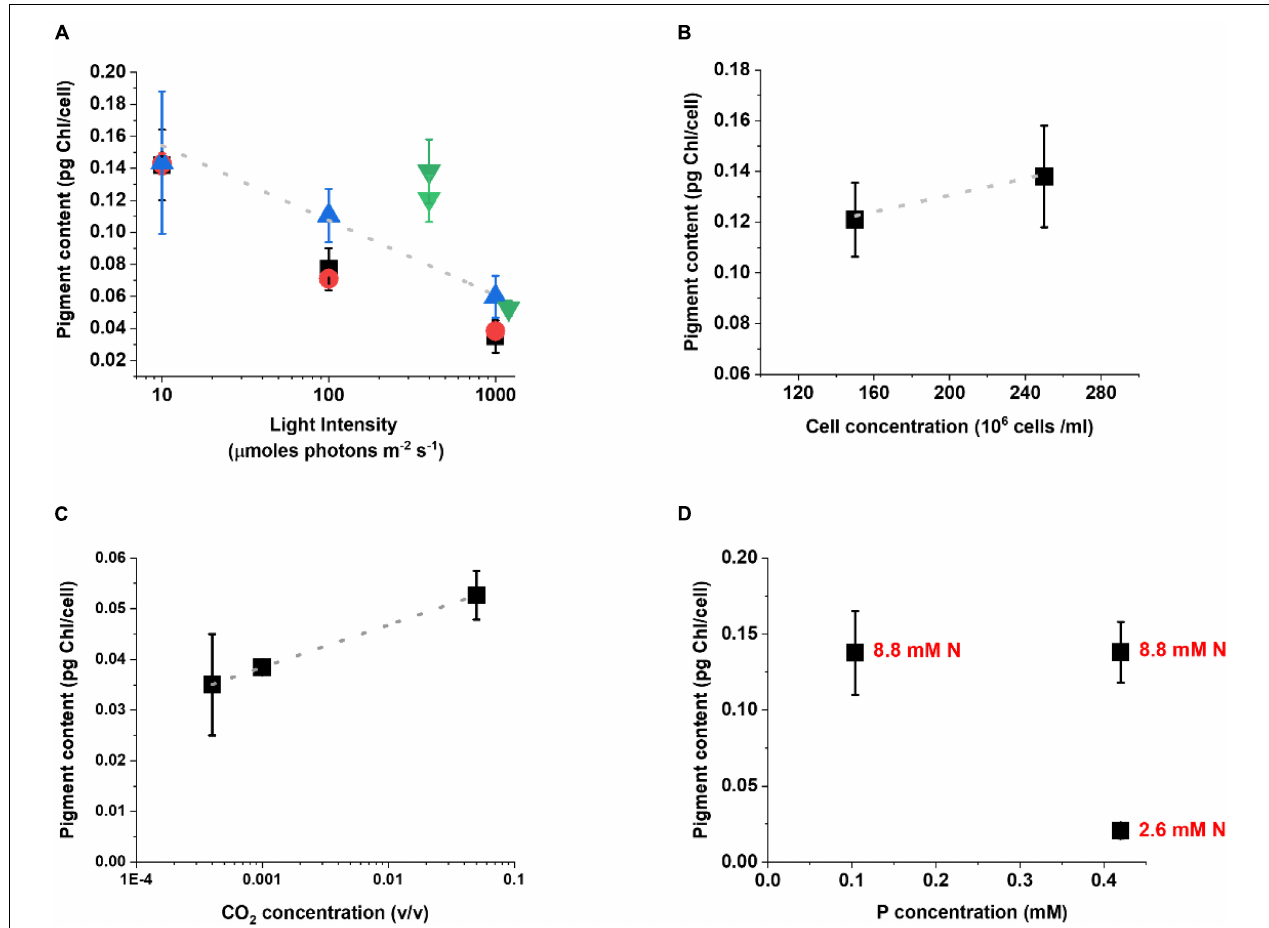
FIGURE 3 | Acclimation response of Nannochloropsis gaditana in a plethora of lab-scale growth conditions. Acclimation is expressed as the change in the Chl content [picograms (pg) of Chlorophyll per cell] as a function of different cultivation parameters, as follows: light intensity (A) ; cell concentration (B) ; CO 2 concentration (C) and nitrogen (N) and phosphorus (P) availability (D) . In panel (A) the trend of Chl reduction as the light intensity increases is maintained regardless of the differences in cultivation support, nutrient, and CO 2 supply. Black squares, data from flasks, both nutrients and carbon are limiting; Red circles, data from lab-scale glass tubes with air bubbling; Blue upward tringles, data from lab-scale glass tubes with air bubbling and excess nutrients; Green downward tringles, data from lab-scale photobioreactors with excess carbon (see Supplementary Table 1 for a complete description of the cultivation conditions). In panel (D) black dots indicate the Chl content as a function of P availability, whilst the corresponding concentration of N for each dot is indicated in red. The growth conditions in which these data were collected are summarized in Supplementary Table 1